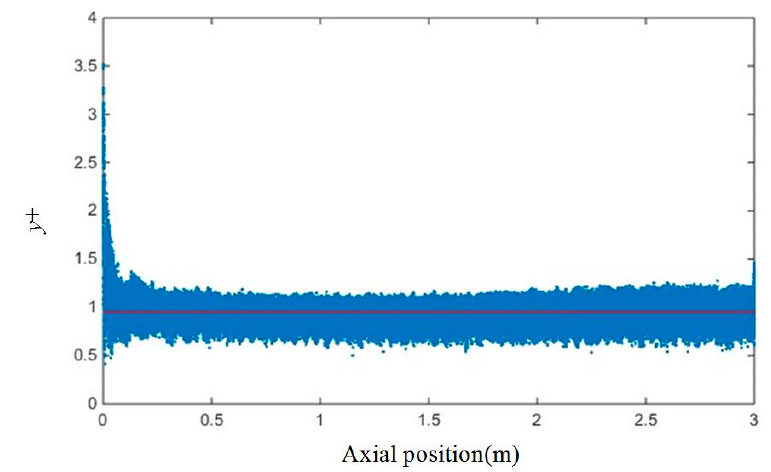
Figure 2. Meshing of the tubular PBR ( D = 50 mm, α = 38.15°, N = 4).